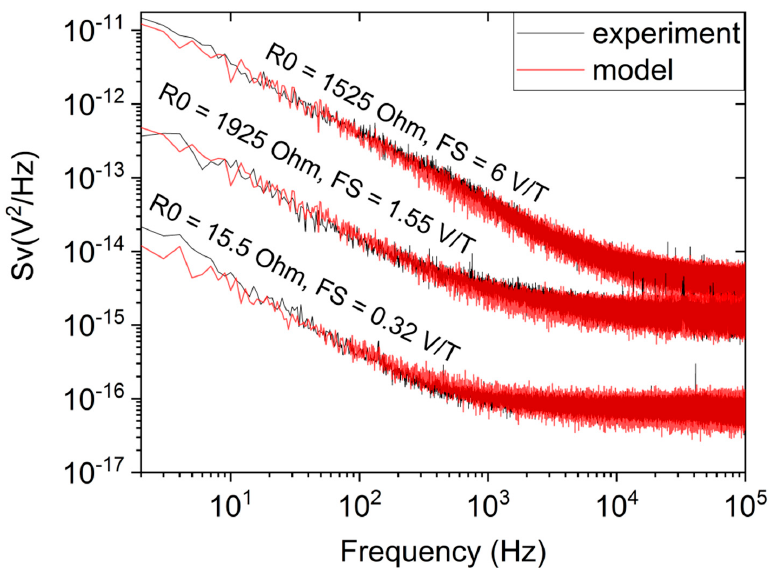
Figure 4. Comparison between experimental noise characteristics (solid black line) and their corresponding best matches in the model (transparent red line) obtained for three representative sensors.